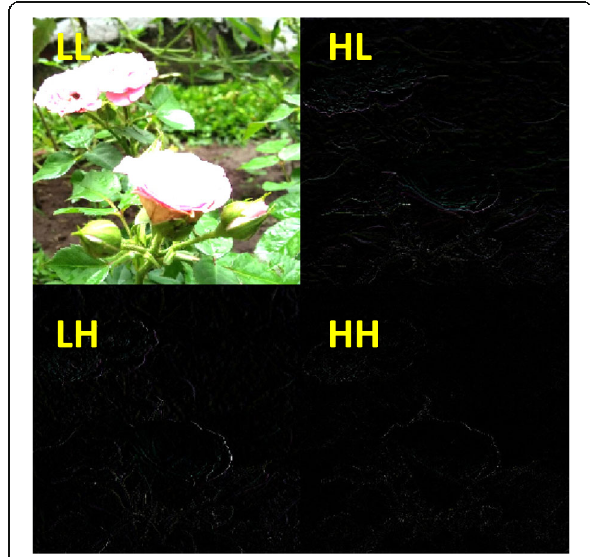
Fig. 11 Wavelet decompositions of an image